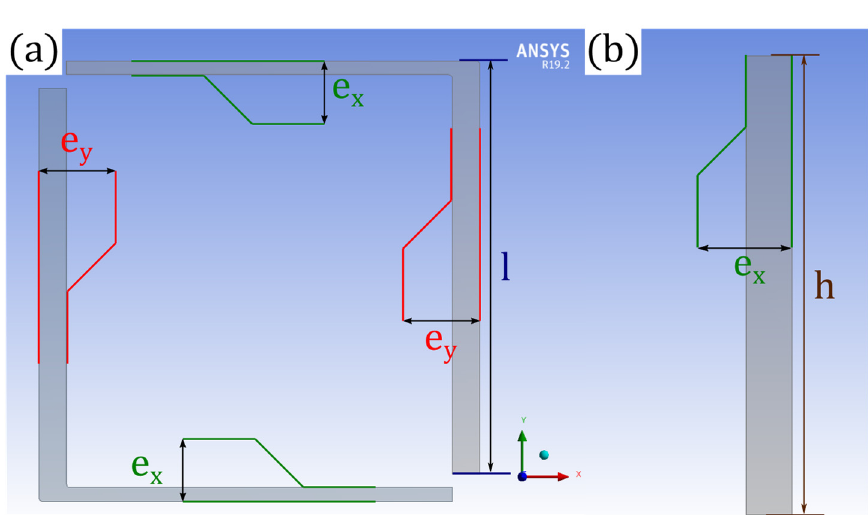
Figure 3. Representation of the geometrical parameters of the spring 1: ( a ) view from XY plan; ( b ) cross section of one beam viwed from ZY plan.